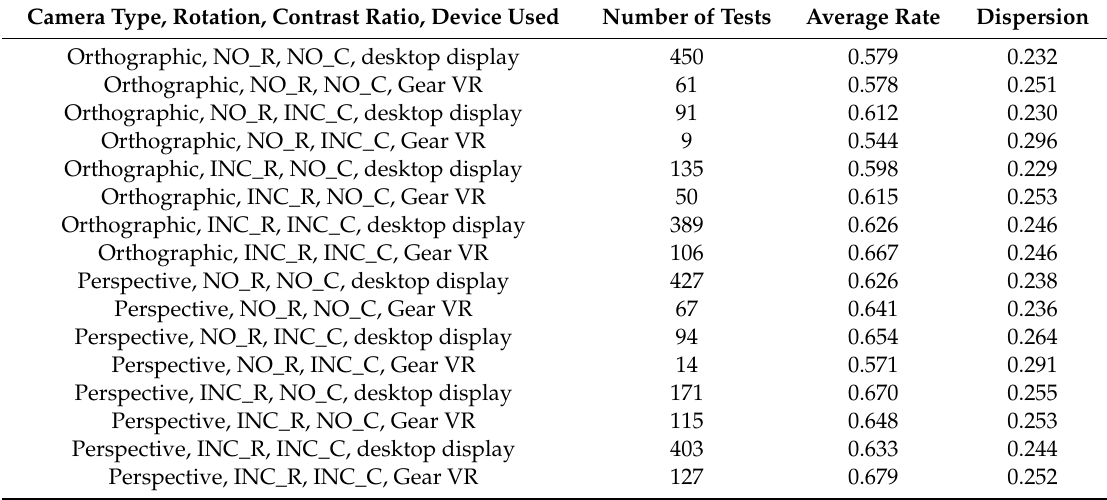
TableA19. Numericalresultsoftheusersregardingthecameratype, rotation, contrastratio, deviceused. Camera Type, Rotation, Contrast Ratio, Device